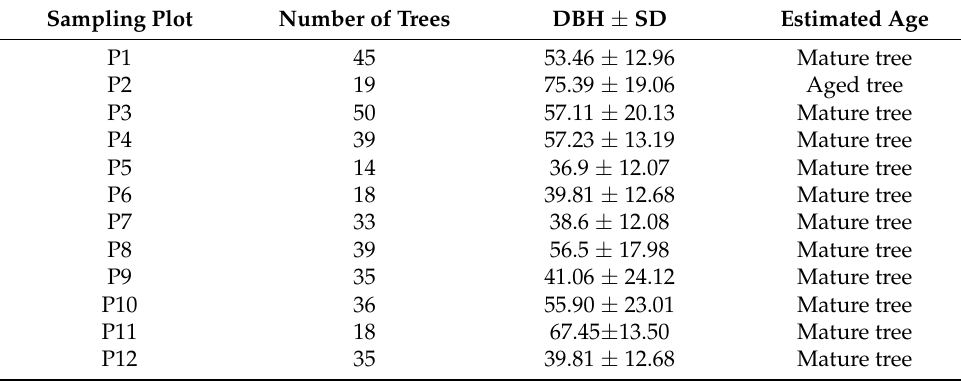
Table 2. Number of cork oaks corresponding to each plot; average diameter breast height (DBH) in cm; standard deviation ( ± SD) and tree estimated age